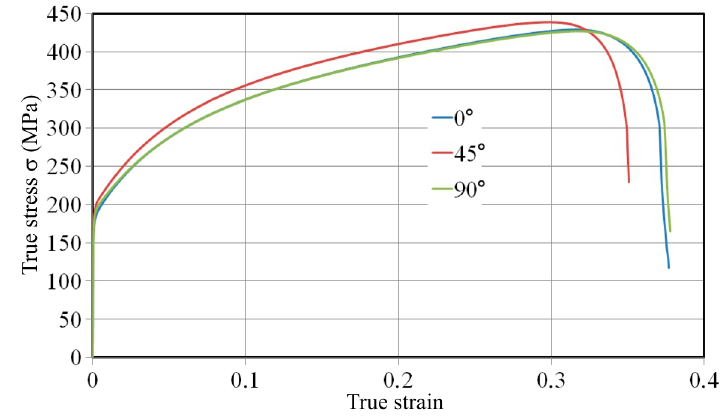
Figure 1. True stress-true strain relation of DC04 sheet.